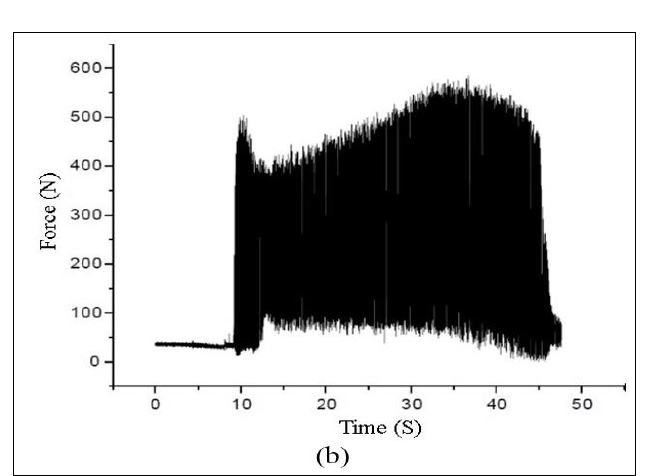
Figure 15b: Sample without sealant (nose radius 0,4 mm): (b) Force spectrum (3rd